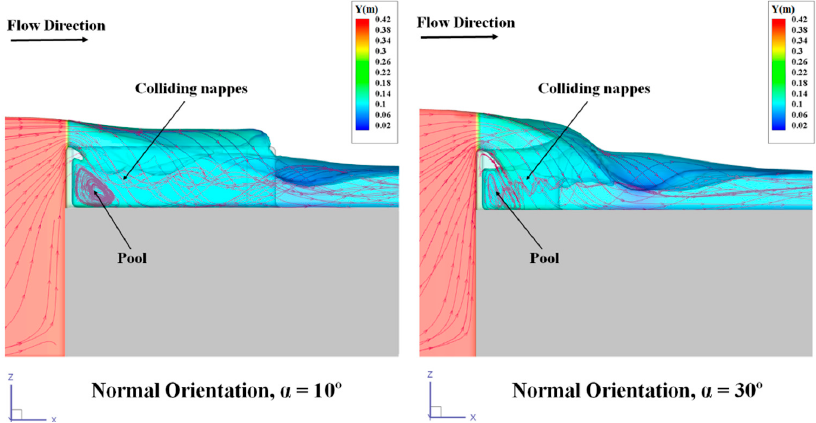
Figure 12. The collision of nappes and circulating flows in the pool at upstream apexes of the TTLW. In Figure 13, the relative energy dissipation ∆ E / E 0 versus the relative critical depth y c / E 0 is presented. Energy dissipation results of vertical drops are compared with the results of Rajaratnam and Chamani [50] and Chamani et al. [51], indicating that TTLW approximately dissipates the maximum amount of energy. Increasing the sidewall angle and weir height (from 8 to 12) and subsequently increasing the dimensionless ratio of y c / E 0 , TTLW reduces more energy with respect to the vertical case. In fact, collision of nappes happens in the upstream apexes of TTLW, generating a localized hydraulic jump condition near it that leads therefore to energy dissipation. Moreover, with the creation of a pool behind the nappes in the upstream apexes of TTLW, circulating flow (in the pool) enhances the turbulent mixing and dissipates a large portion of energy (see Figure 12). It should also be noted that a weak hydraulic jump downstream of TTLW contributes to dissipating a higher and significant portion of energy. Figure 13. Energy dissipation on TTLW with vertical drop and maximum energy dissipation [31] ( ∆ E / E 0 versus y c / E 0 ), ( a ) P = 8 cm, ( b ) P = 10 cm, ( c ) P = 12 cm. ( a )